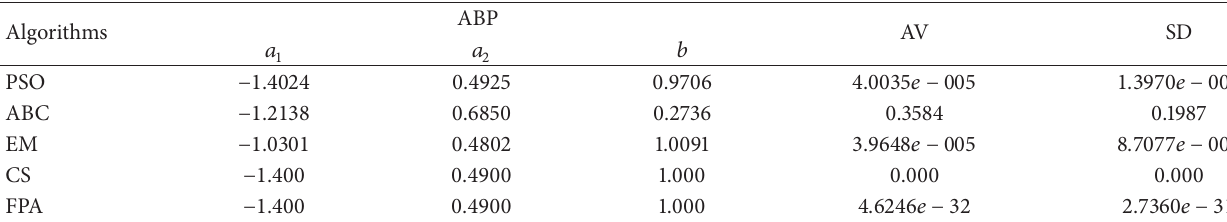
Table 2: Performance results of the second experiment.